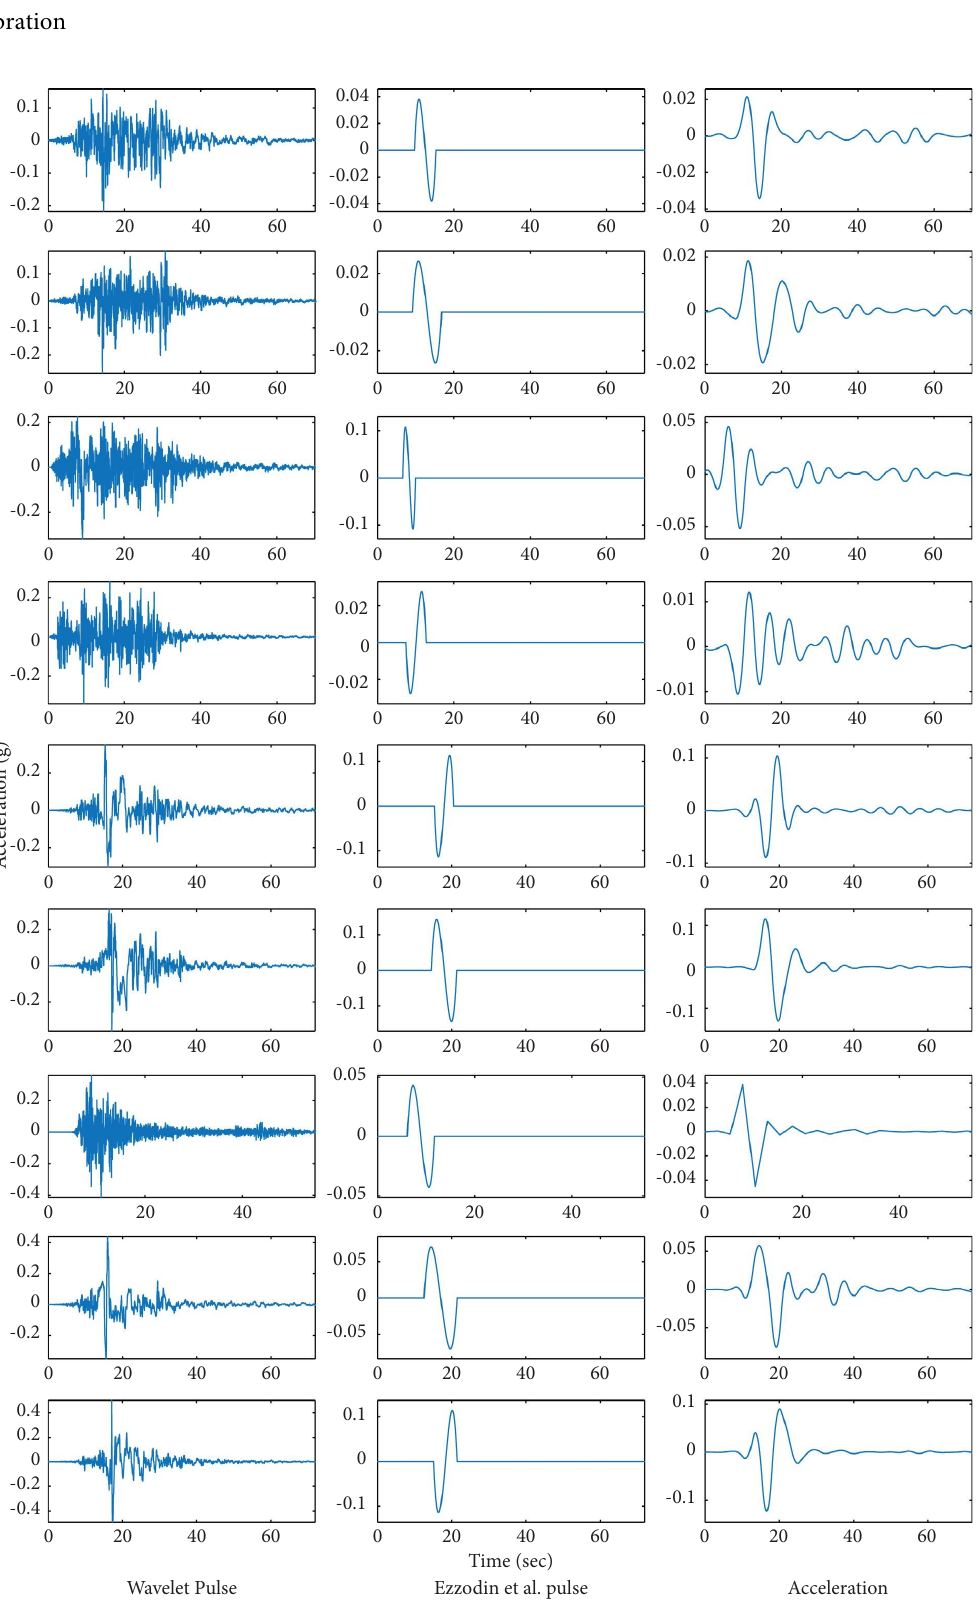
Figure 6: Acceleration components and extracted